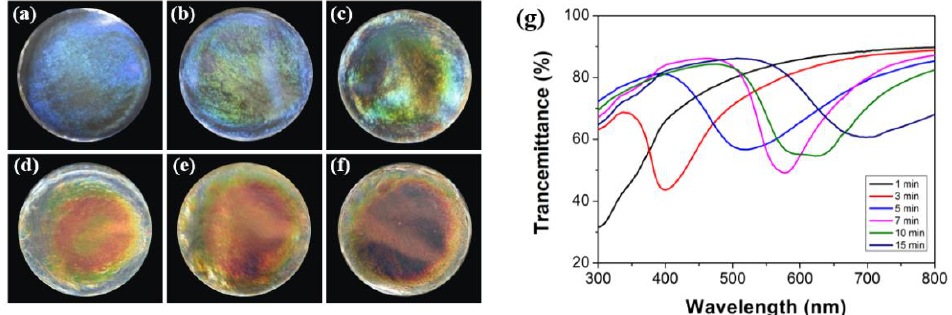
Figure 3. Photos of CNC films treated with different ultrasonic time ( a ) 1 min; ( b ) 3 min; ( c ) 5 min; ( d ) 7 min; ( e ) 10 min; ( f ) 15 min (d = 3.5 cm); ( g ) Transmission spectra of CNC films treated with different ultrasonic times.